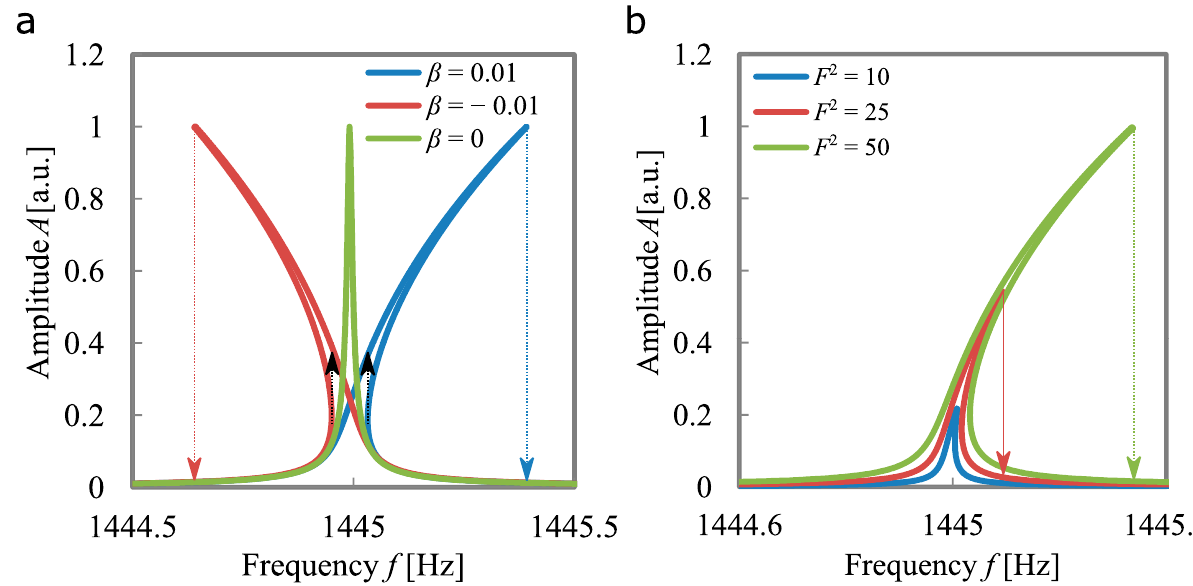
Figure 2. Numerically simulated frequency response of a Duffing oscillator for varying stiffness coefficients ( a ) and for varying actuation forces ( b ).